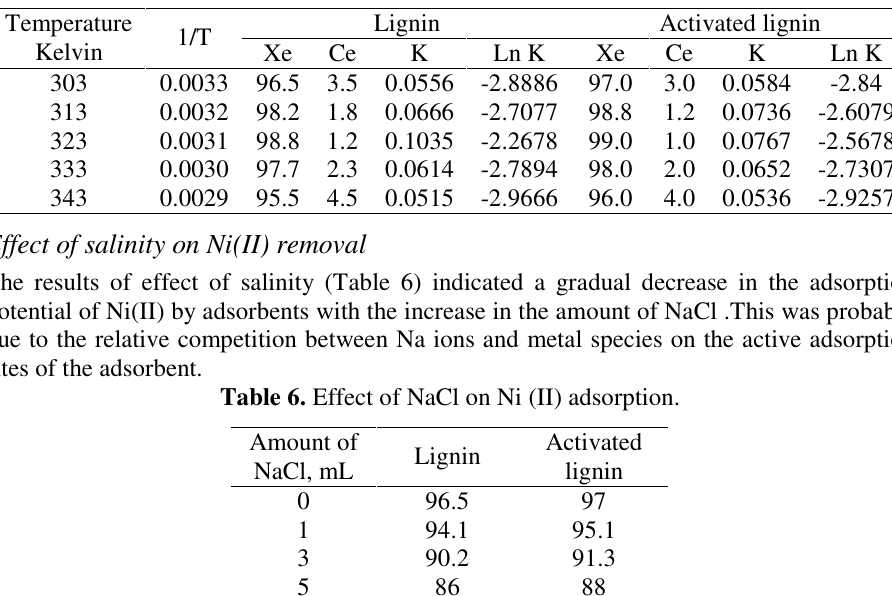
Table 5. Effect of temperature on Ni(II) adsorption.